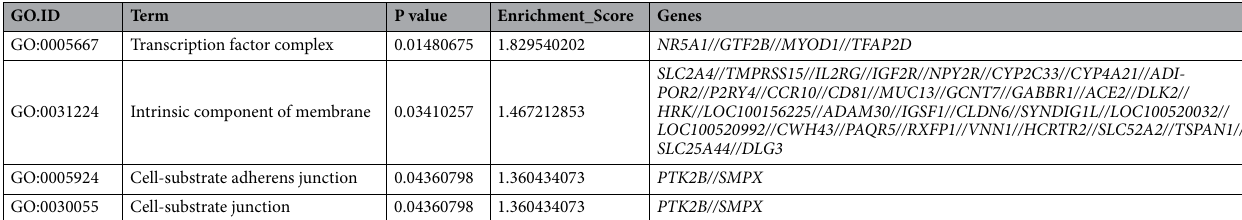
Table 5. The Cellular components with up-regulated gene enrichment